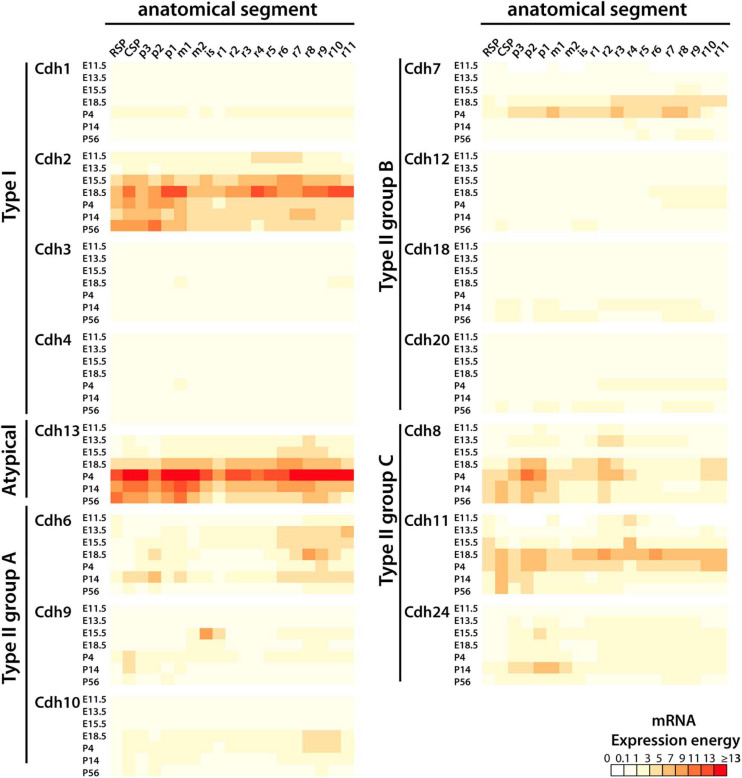
Developmental expression of classical cadherins and Cdh13 mRNA along the anterior–posterior axis (anterior is to the left). The heatmap displays the mRNA expression energy detected by ISH of type I (Cdh1, Cdh2, Cdh3, and Cdh4) and type II cadherin group A (Cdh6, Cdh9, and Cdh10), group B (Cdh7, Cdh12, Cadh18, and Cdh20), group C (Cdh8, Cdh11, and Cdh24), and the atypical Cdh13 in each neuroanatomical segment (at ontological level 3) at E11.5, E13.5, E18.5, P4, P14, and P56. RSP, rostral secondary prosencephalon; CSP, caudal secondary prosencephalon; p, prosomere; m, mesomere; is, isthmus; r, rhombomere.